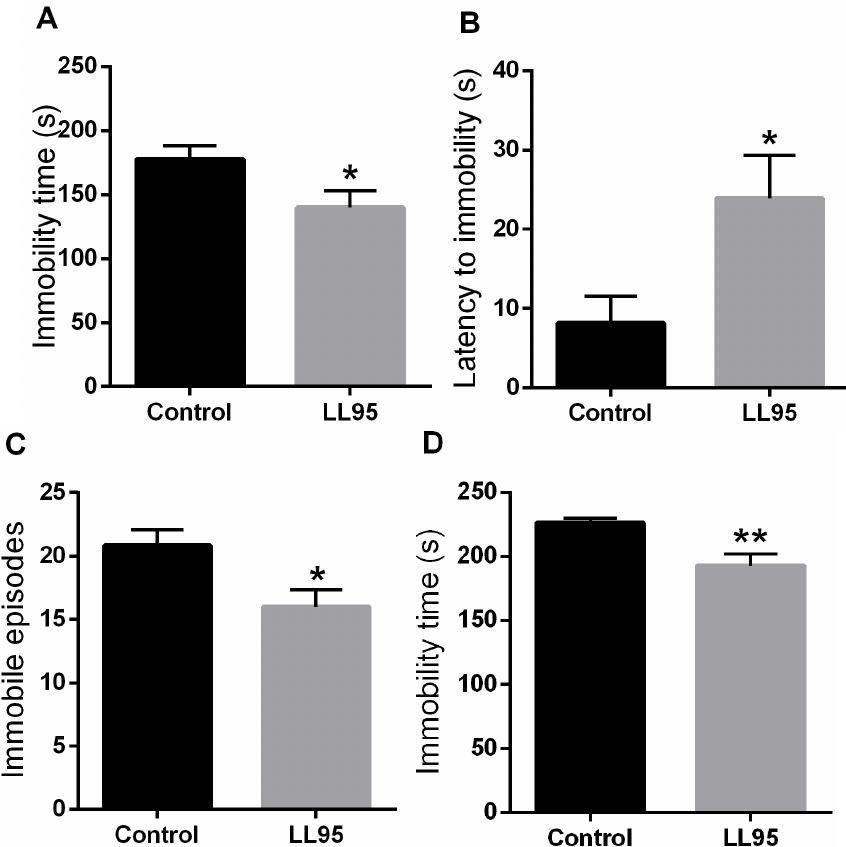
Figure 3. Effect of L. lactis LL95 on depressive-like behaviour in the TST and FST. L. lactis LL95 induced a decrease in the immobility time ( A ), an increase to the latency for first episode of immobility ( B ), and a decrease on immobile episodes ( C ) in TST. L. lactis LL95 induced a decrease in the immobility time in FST ( D ). Data are expressed as mean ± S.E.M. ( n = 6). * p < 0.05, ** p < 0.01 vs. control group.